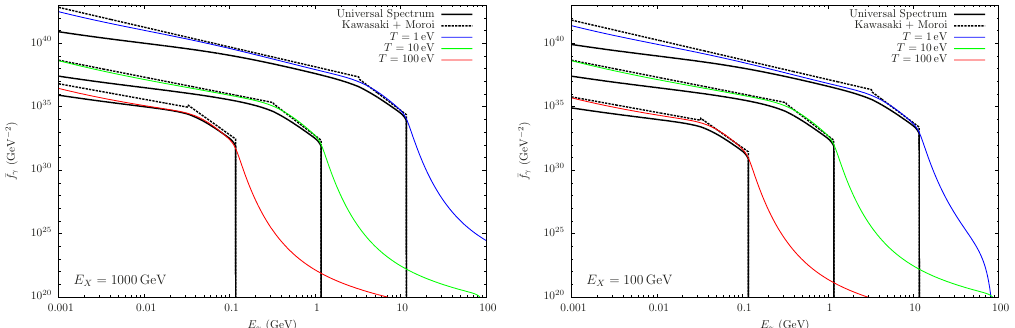
Figure 1 . Photon spectrum (cid:22) f (cid:13) ( E ) for single photon injection with energy E X = 1000 GeV (left) and 100 ; GeV (right), for temperatures T = 1 ; 10 ; 100 eV. Also shown are the predictions of the universal spectrum (solid) and the parametrizations of Kawasaki and Moroi given in ref. [40].